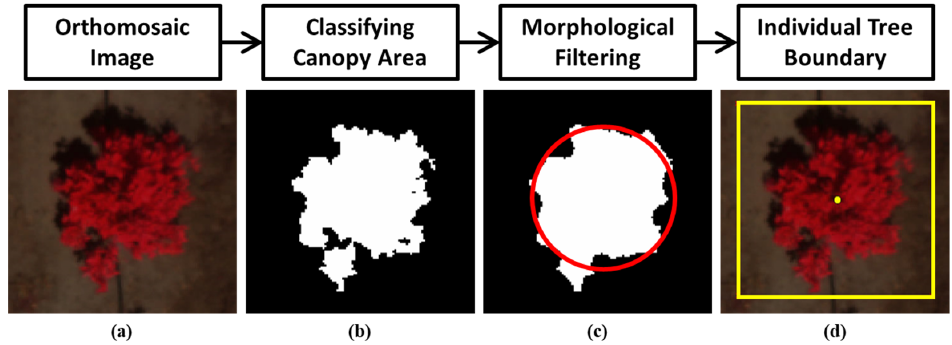
Figure 2. Example of individual tree detection: ( a ) a tree in a color-infrared (CIR) image, ( b ) canopy cover from the normalized di ff erence vegetation index (NDVI) and the canopy height model (CHM), ( c ) individual tree segment after morphological filtering with the equivalent diameter (red circle), and ( d ) centroid of the individual tree (yellow dot) and individual tree boundary (yellow